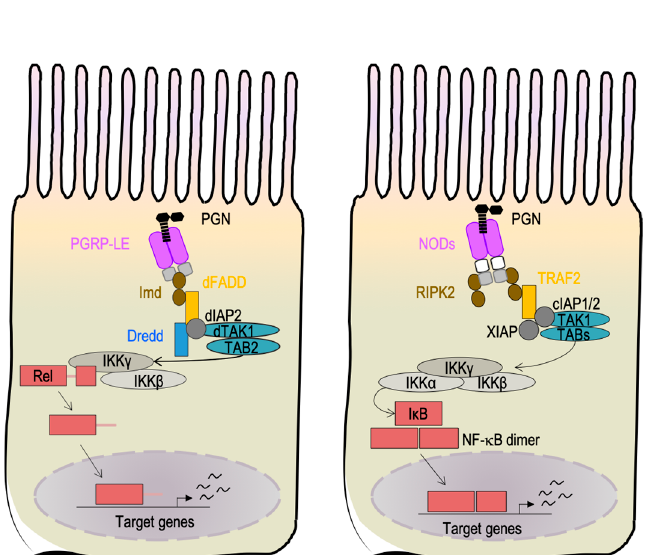
Figure 3. Intracellular peptidoglycan (PGN) is detected by intracellular receptors and activates the NF- κ B signaling pathway in Drosophila melanogaster and human enterocytes. Intracellular PGN is detected by the PGRP-LE receptor in Drosophila melanogaster ( A ) or by NOD receptors in human ( B ). PGN-receptor interaction triggers the NF- κ B signaling cascade (Imd pathway in Drosophila ), which results in the production of antimicrobial peptides (AMPs). The orthologous proteins are represented by the same shape, color and position in the pathways.